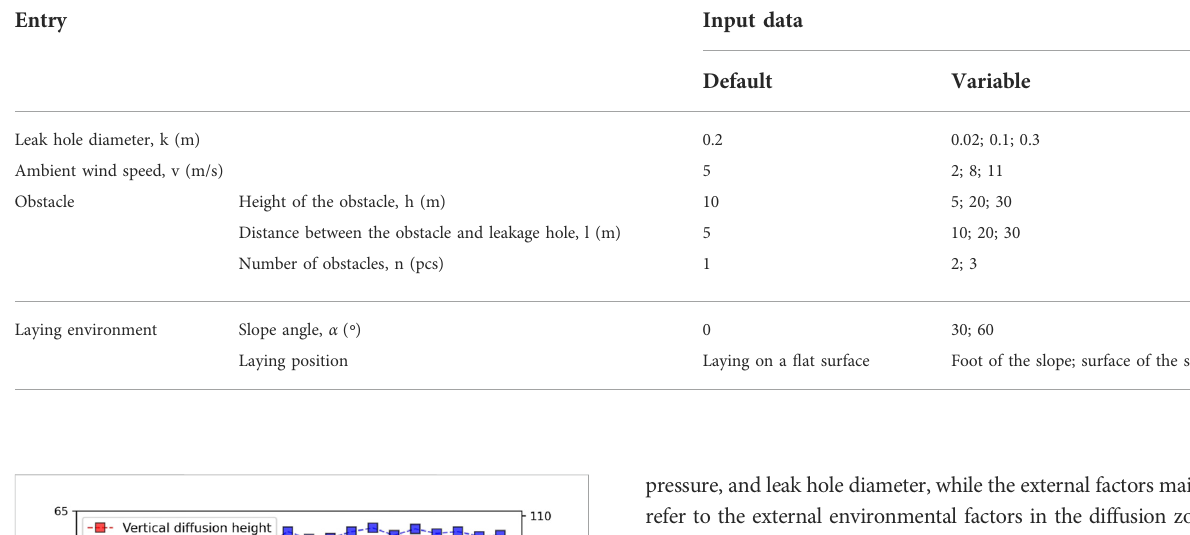
TABLE 1 Setting of simulation parameters.